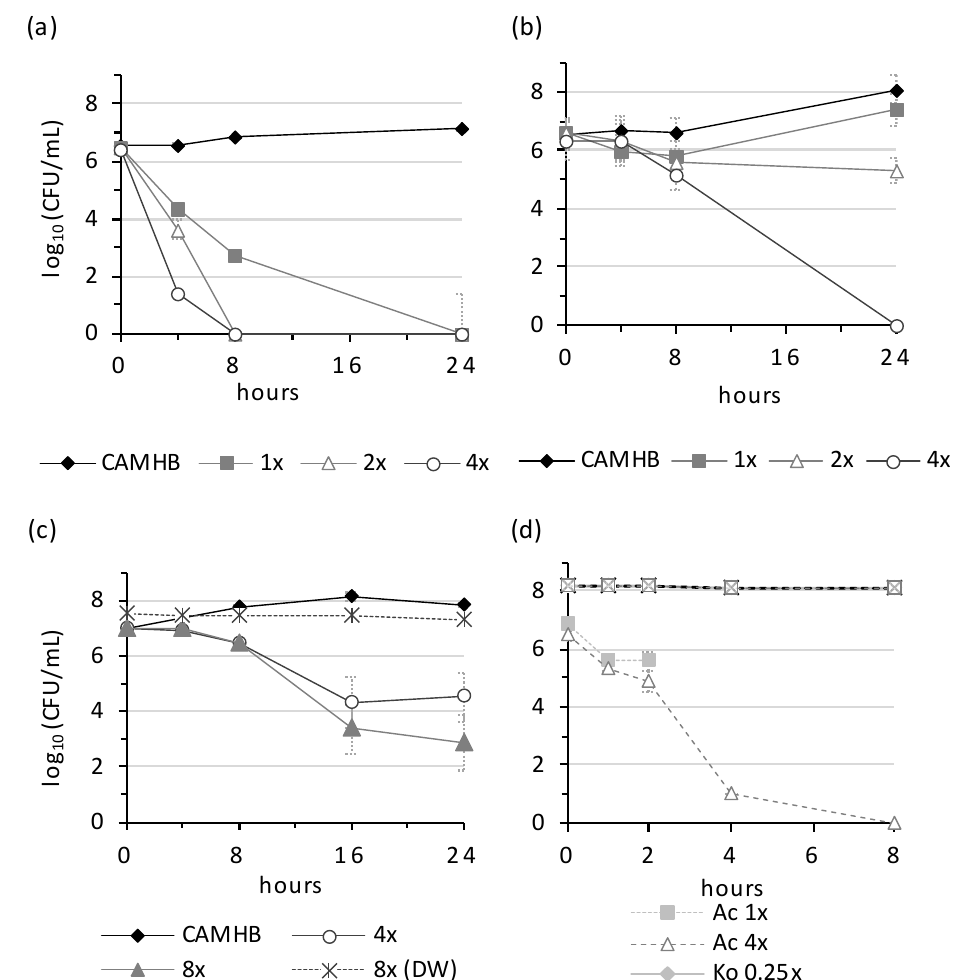
Figure 3. Bactericidal rates for NPBD against Gram-negative species. ( a ) Moraxella catarrhalis RMIT211/2, ( b ) Yersinia enterocolitica ATCC23715, ( c ) Proteus vulgaris ATCC13315 in CAMHB or distilled water (DW); and ( d ) Acinetobacter calcoaceticus RMIT3131 and Klebsiella oxytoca RMIT 180/4 in distilled water. NPBD was tested at multiples ( × ) of the MICi in CAMHB with 1% v / v DMSO. Limit of detection was <10 cfu. Assays repeated two to four times and average viable counts reported.